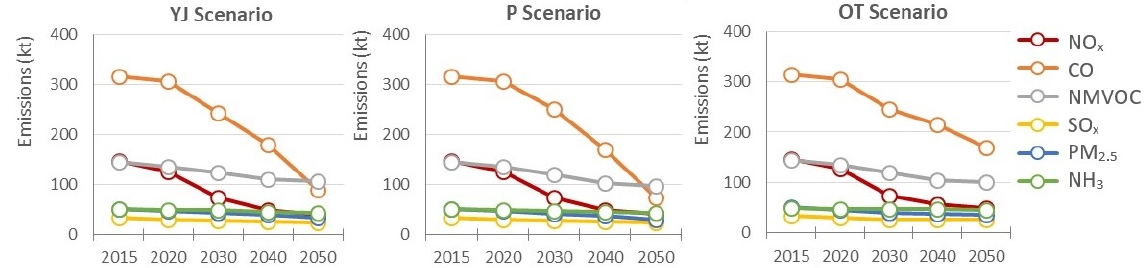
Figure 8. Air pollutant emission trajectories (kt) for three scenarios: Yellow Jersey (YJ), Pack (P), and Off Track (OT).